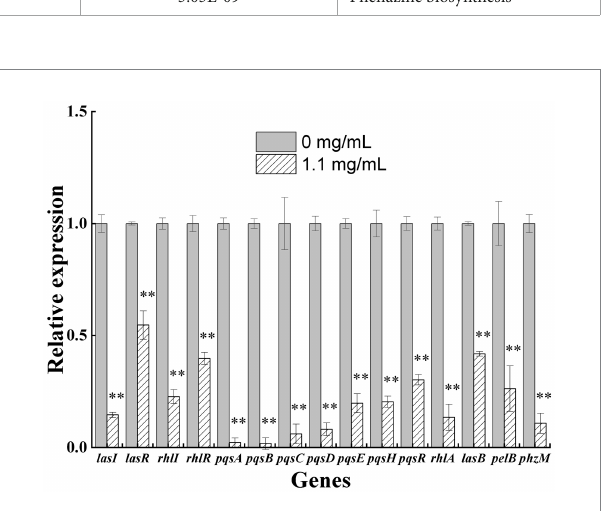
FIGURE 3 Quantitative reverse transcription polymerase chain